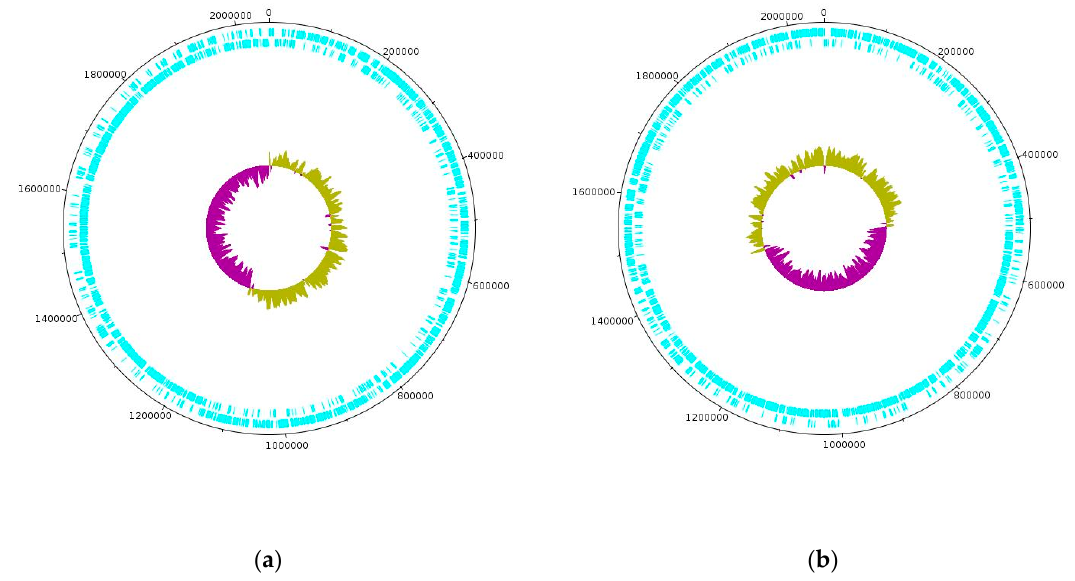
Figure 1. Genetic maps of circular closed genomes strains of L. helveticus D75 ( a ) and L. helveticus D76 ( b ). The coding nucleotide sequences for the direct (outer circle) and reverse (inner circle) strands of genomic DNA are coloured blue in the outer ring of the genetic map, while the inner ring shows the relatively high (olive) and slightly lower (dark magenta) GC ratio for D75 ( a ) and D76 ( b